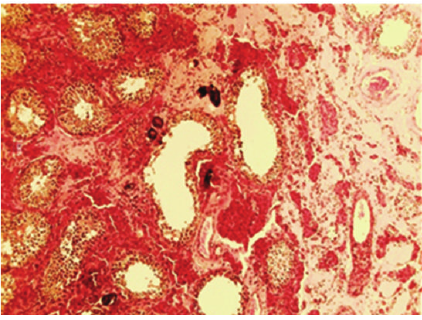
Figure 3: Testicular parenchyma with calcified S. mansoni